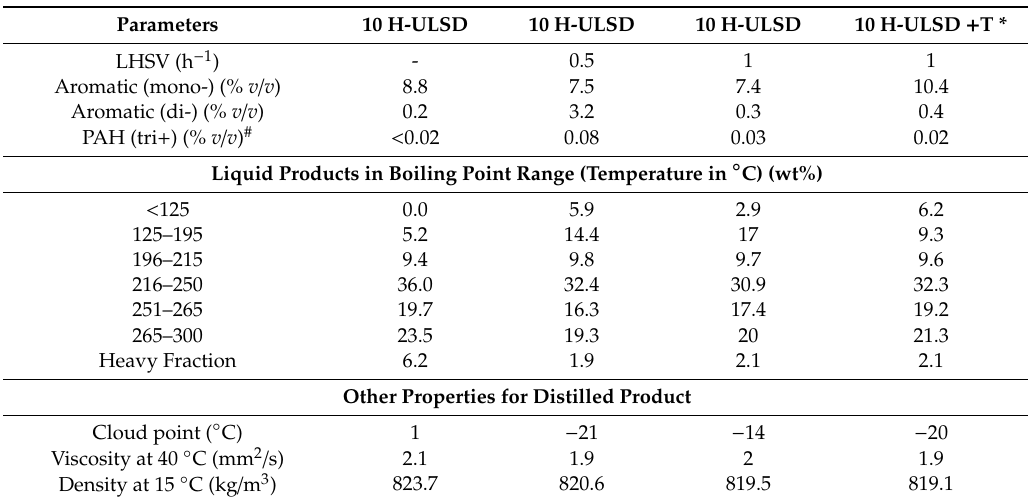
Table 5. Physicochemical properties of the hydro-isomerisation by Pt / H - β -zeolite on T = 240 ◦ C at P = 5 Mpa and GHSV = 600 mln / (g.cat).h. Note: * 10% Toluene in 10 H-ULSD and # Poly aromatic hydrocarbon (PAH) (tri + ) should be less than 0.02% with diesel